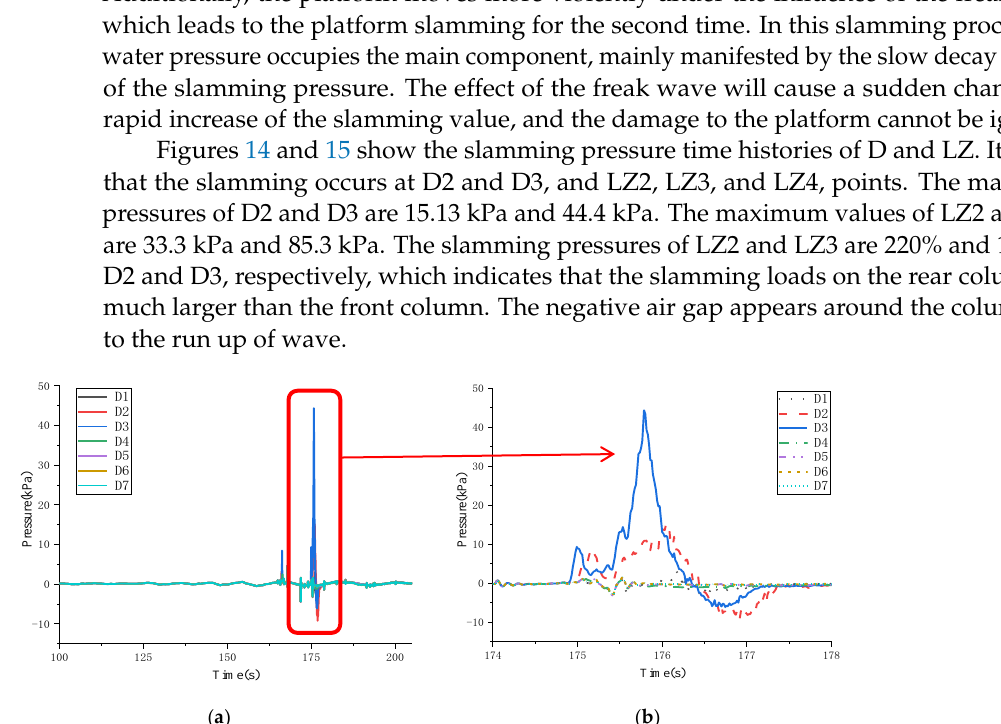
( b ) Figure 15. Pressure time series of LZ1 – LZ7 on wavefront surface of rear column. ( a ) Global graphics. ( b ) Detail graphics. Negative pressures can be found in Figures 14b and 15b, where it is seen that these negative pressures last for around 1 s when the slamming pressure is reduced to 0 kPa. The occurrence of negative pressures means that waves subside rapidly after the impact, and there is no air to supplement in time. Freak waves run up at the junction of the bottom of the deck and the column. Due to the fact that the two vertical plates are connected at 90°, the waves are squeezed and collided here, showing strong nonlinear characteristics. 4.1.2. Slamming Loads in Beam Sea The slamming load on offshore structure in beam sea is rare; however, it should be discussed as an exceptional hazardous working condition. Figure 16a shows the wave slamming on the monitoring points arranged on the front column wavefront surface (A1 – A6), and Figure 16b shows the wave slamming on the monitoring points located on the rear column wavefront surface (B1 – B6). It can be seen that the pressure distribution on the front column wavefront surface is relatively gentle and the pressure distribution on the rear column wavefront surface is relatively steeper. The reason is that when the wave is a transverse wave, the front column wavefront surface is located on the side of the platform, and there is no deck cover at the top. However, there is wave interference on the wave face of the rear column, and there is a shadowing effect between the column and the deck. So, the nonlinear characteristics of wave slamming on the rear column are more promi- nent.